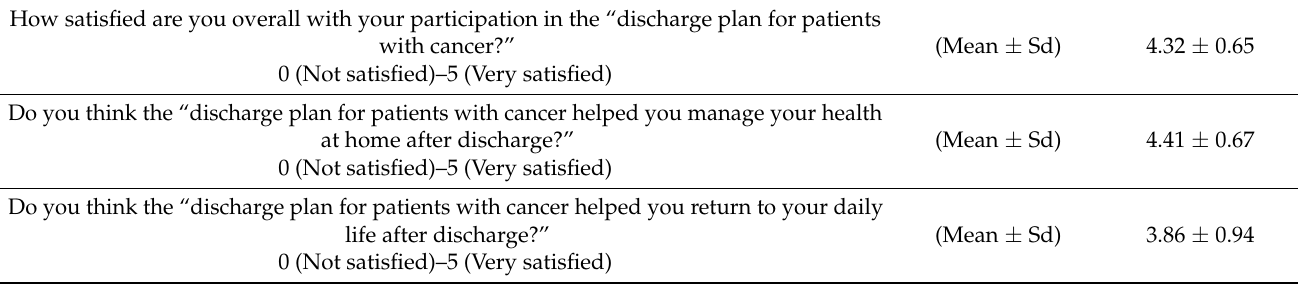
Table 4. Patient Satisfaction Survey Results ( n = 22, missing =